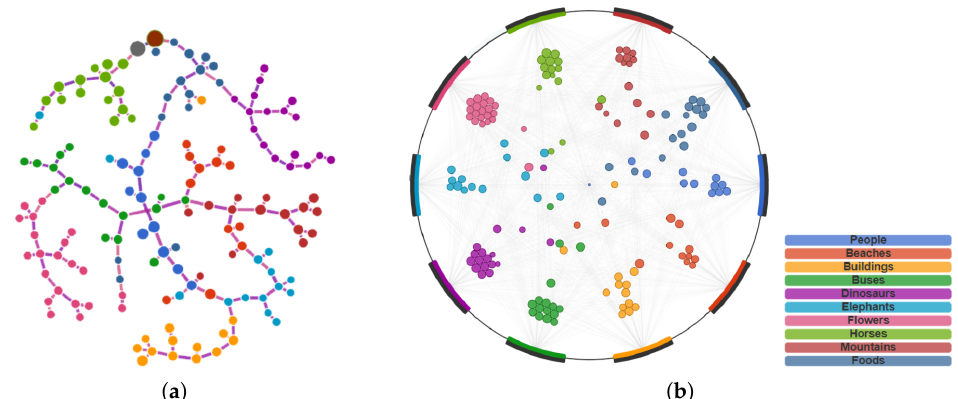
Figure 10. Comparison between GFF ( a ) and Attribute-RadViz ( b ) under the same color encoding (each attribute assumes the color of the strongest correlation per label). While Attribute-RadViz highlights the relationships between features and data labels, in GFF the final tree displays the relationship among the features